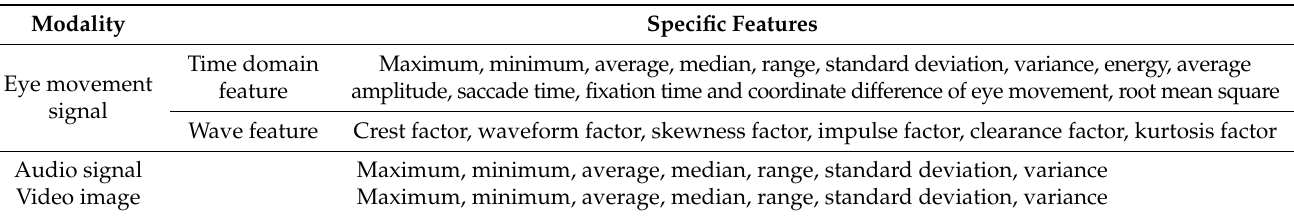
Table 1. The specific features of the three modalities.